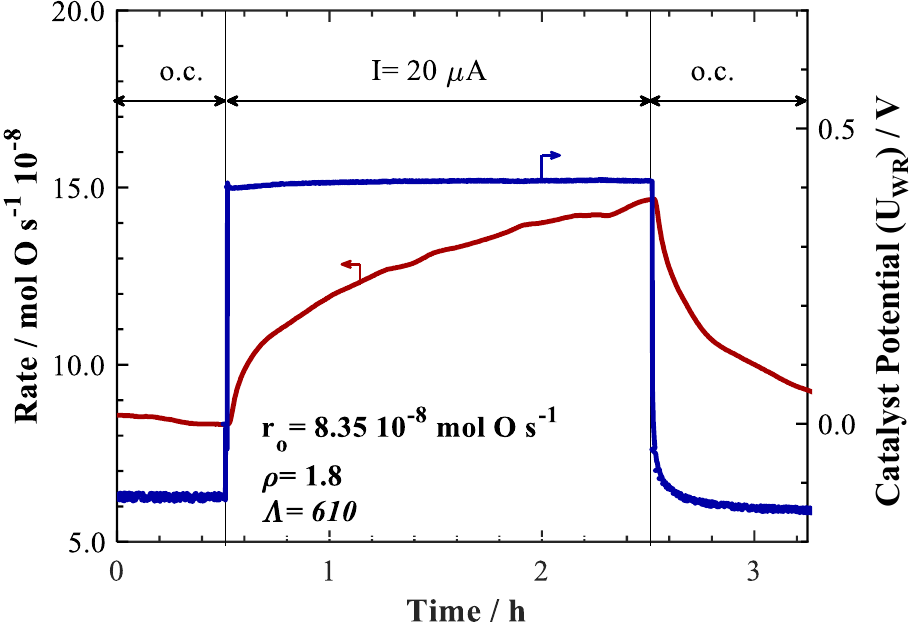
Figure 4. Transient rate response of Pd nanoparticles to a current step change. o.c.: open-circuit. Conditions: T = 450 °C, 2 kPa of CH 4 and 4 kPa of O 2 . Flow rate: 100 ccm.